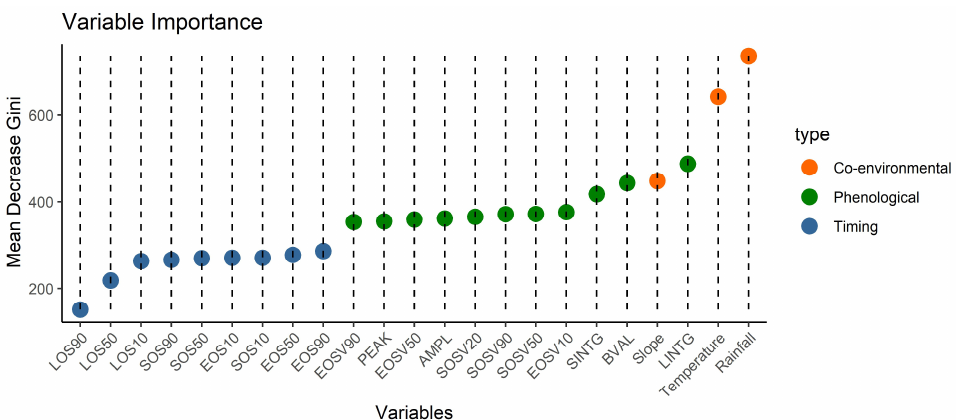
Figure 10. 3D-scatterplots illustrating the input features (phenology, co-environmental) differences between croplands versus non-croplands. This knowledge is used in the random forest algorithm to classify cropland versus non-croplands. The DOY (Day of Year) of SOS and EOS begins on the 1st September of each year.